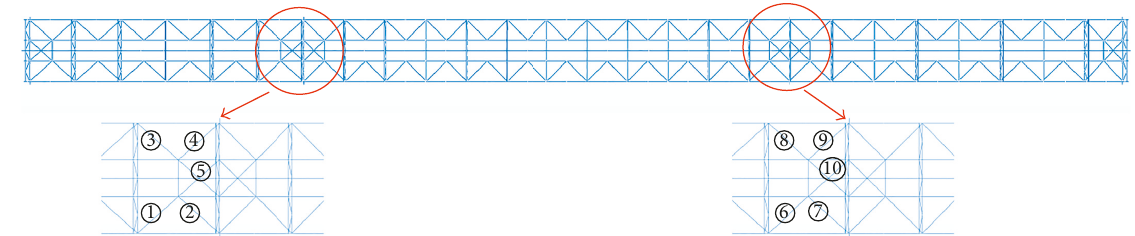
Figure 34: Locations of the buckled lower bracing members.